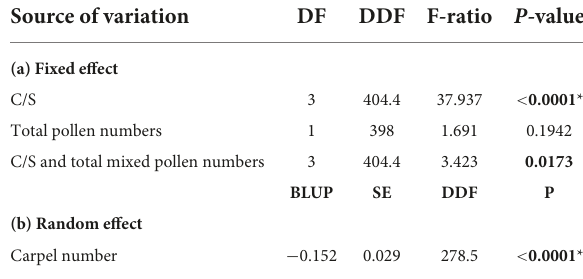
TABLE 1 The number of flowers and carpels applied to hand-pollination and young fruit in each treatment.